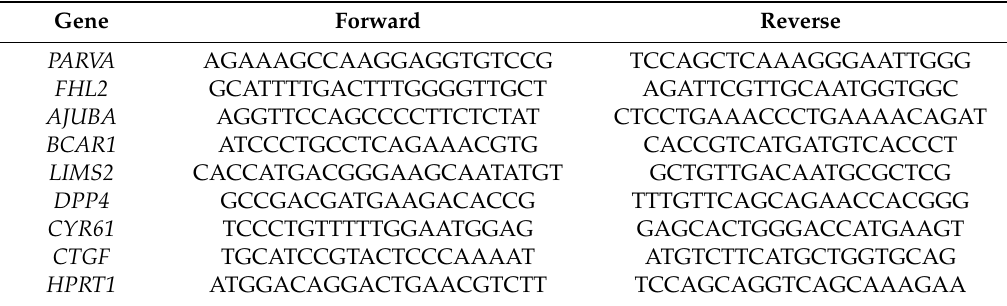
Table 1. The qPCR primers were designed using NCBI Primer-BLAST and the primer sequences. Gene Forward Reverse PARVA